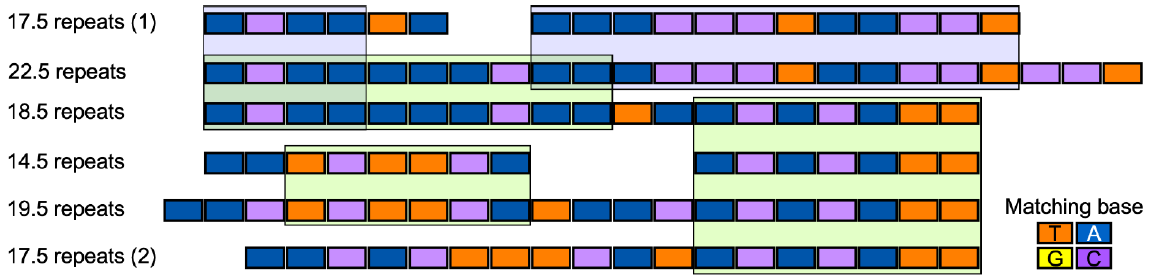
Figure 9. The predicted effector binding elements (EBEs) of the transcription activator-like effectors (TALEs) of six X. citri pv. glycines strains. The EBEs were predicted based on the binding specificity of the repeat variable di-residue sequences with a web-application of TALE target site finder, TALgetter v2.3 in a local Galaxy server (https://www.jstacs.de/index.php/TALgetter, accessed date: 1 August 2021). Five conserved domains are highlighted with shaded boxes.